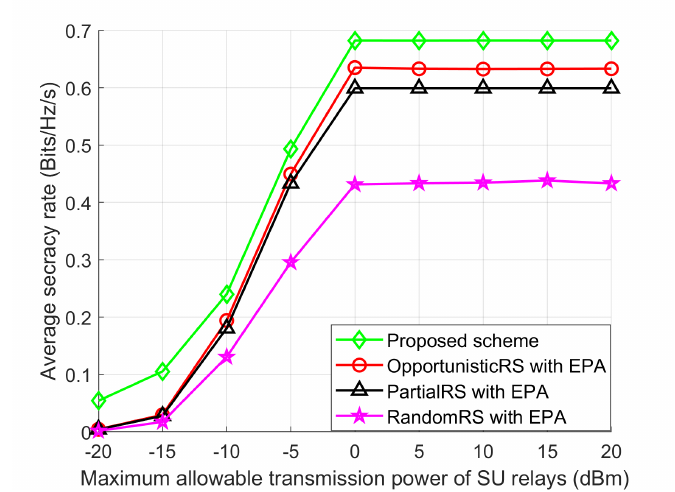
Figure 6. Average SR performance with P max